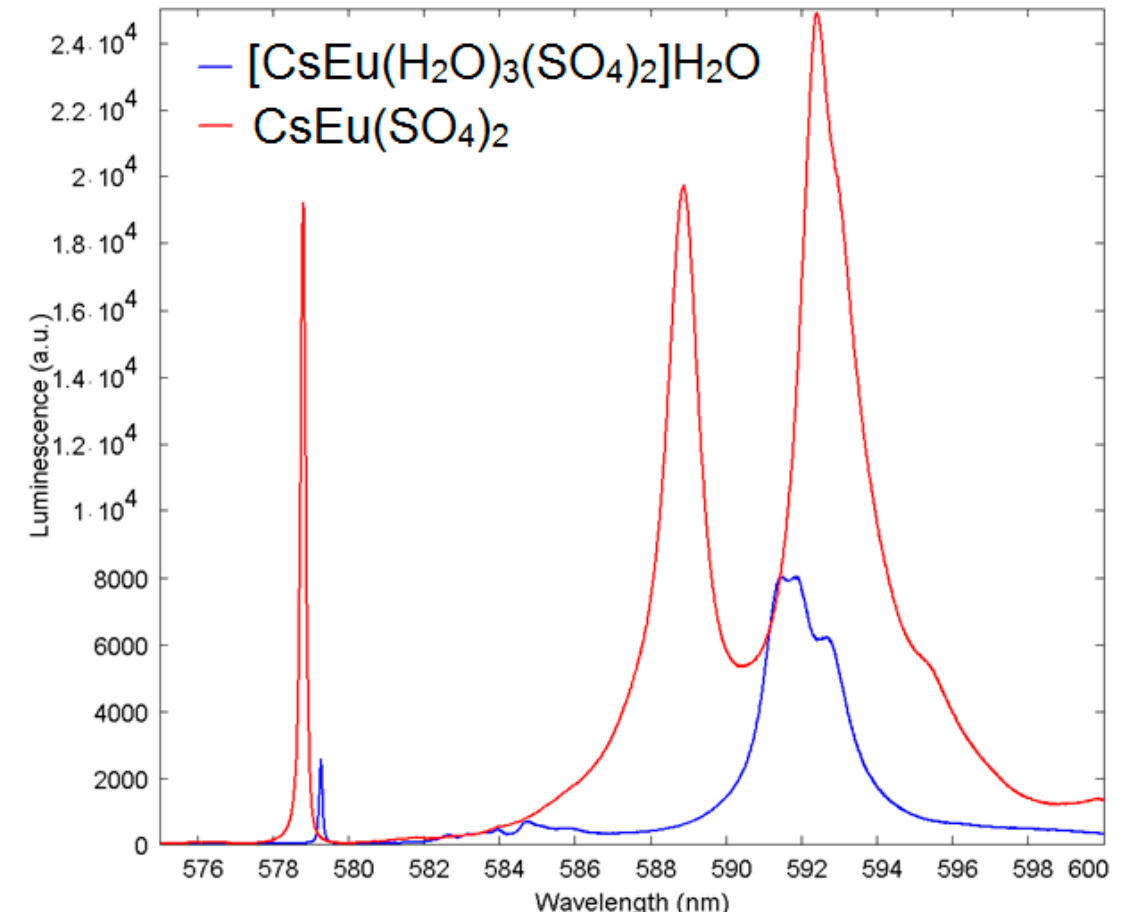
Figure 15. Luminescence spectra of Eu 3+ in [CsEu(H 2 O) 3 (SO 4 ) 2 ]·H 2 O (blue) with respect to CsEu(SO 4 ) 2 (red) in the vicinity of the ultranarrow line 5 D 0 - 7 F 0 demonstrating the shift of ultranarrow line.